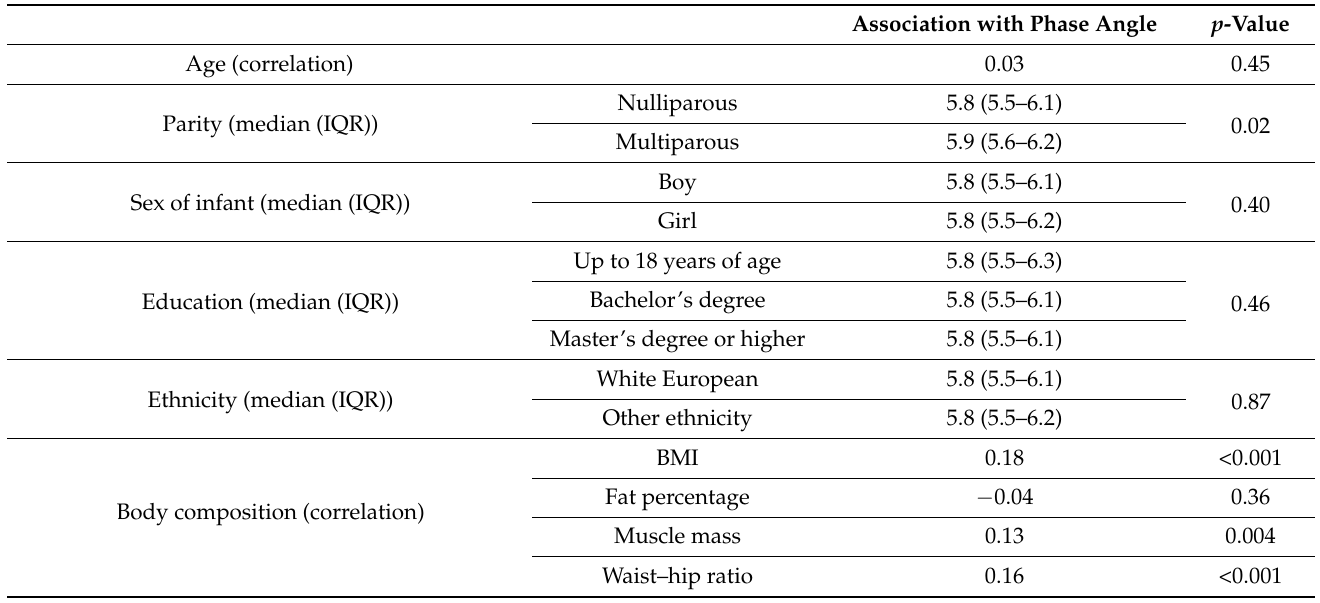
Table 2. Association between phase angle and participant characteristics at 6 weeks